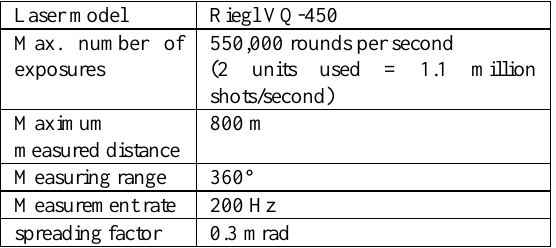
Table 2 . Laser scanner specifications.